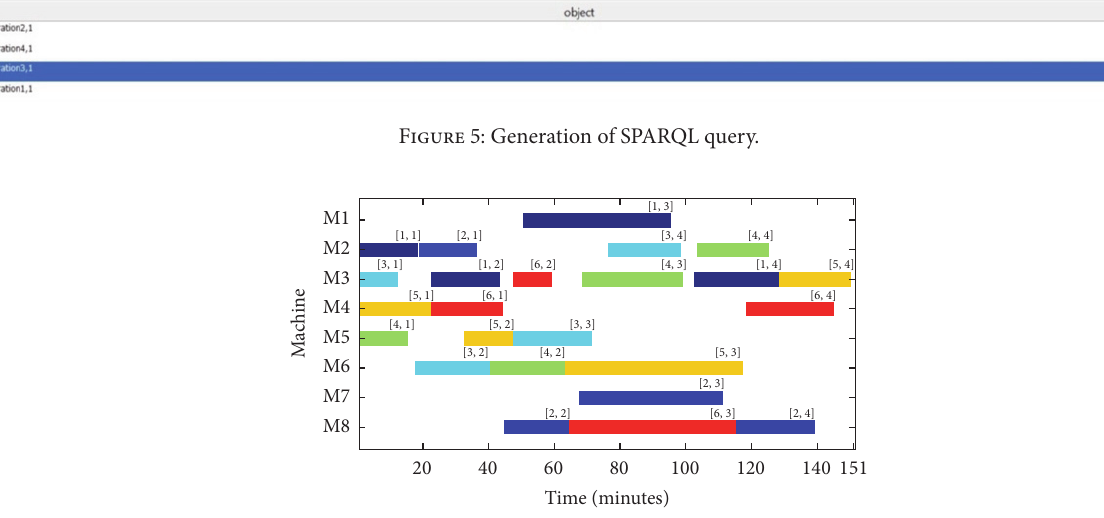
Figure 6: A Gantt chart showing optimal process plan decision for 6 × 8